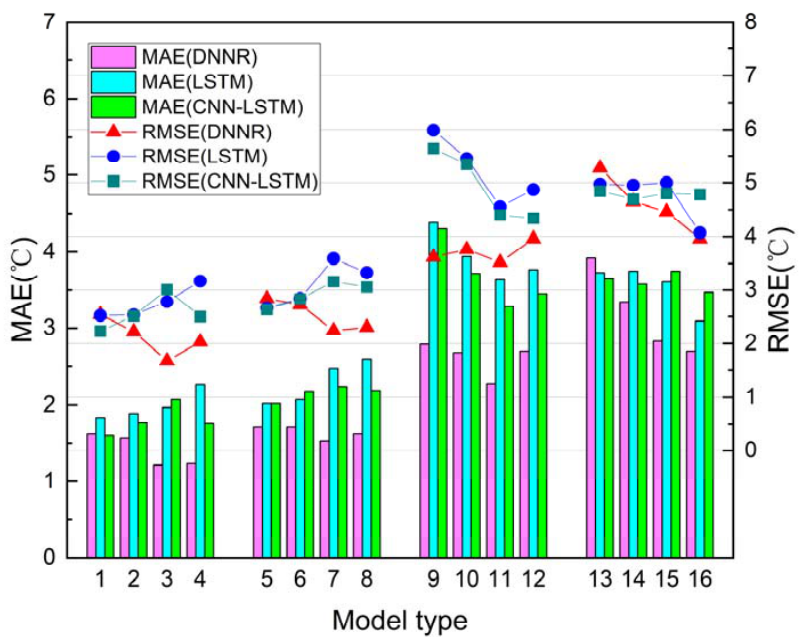
Figure 11. The RMSE and MAE of the best experimental model for Greenhouse B humidity under 16 datasets.